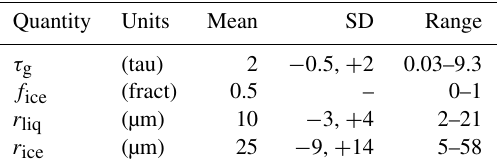
Table 1. Statistics of cloud properties. Standard deviations were calculated for the logarithms of cloud optical depth referenced to the geometric limit ( τ g ), effective radius of liquid ( r liq ), and ef- fective radius of ice ( r ice ) because distributions for the logarithms were found to be more Gaussian in shape; these standard deviations were converted to positive and negative linear standard deviations for these quantities. The ice fraction, f ice , peaks strongly at both limits; thus no standard deviation is provided.